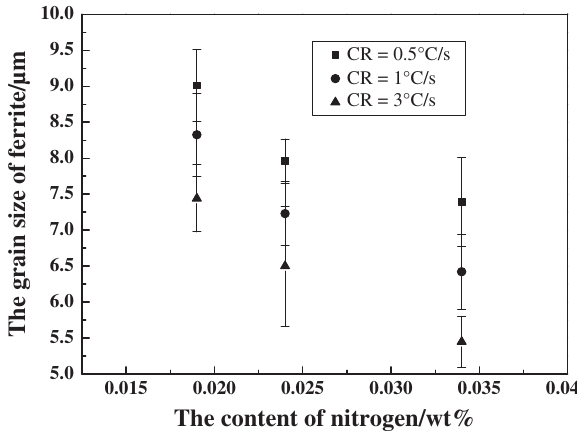
Figure 4: The size variation of ferrite grain with cooling rate in VN1 (0.23 V – 0.019 N), VN2 (0.22 V – 0.024 N) and VN3 (0.22 V – 0.034 N). The error bars represent the standard deviation of grain sizes.